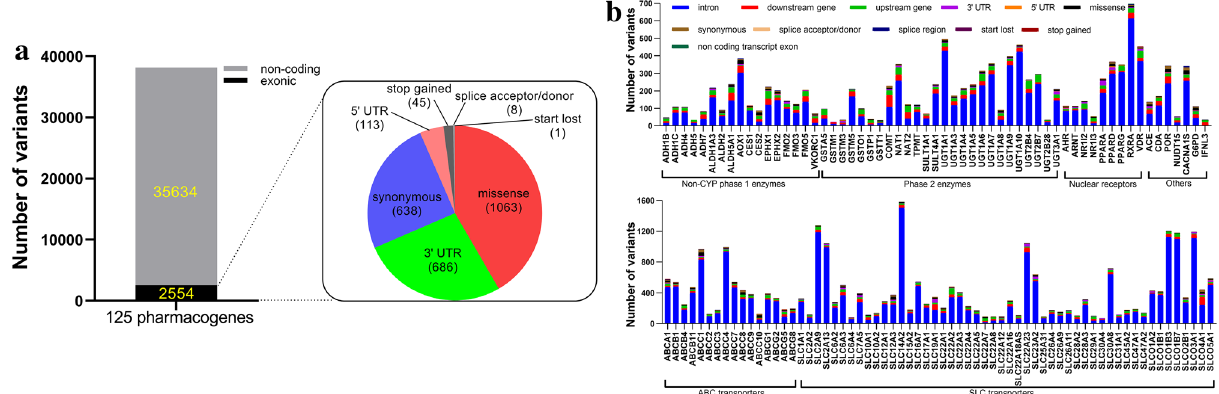
Figure 2. Gene region pattern of 125 pharmacogenes. ( a ) Of these 38,188 variants, 35,634 variants were non-coding ones (intronic, upstream and downstream regions) while 2554 (6.7%) were exonic variants. Pie chart showing the distribution of the identified 2554 exonic variants. ( b ) Number of variants with different gene region distributions in each of ABC transporters, SLC transporters, non-CYP phase 1 enzymes, phase 2 enzymes, nuclear receptors, and others